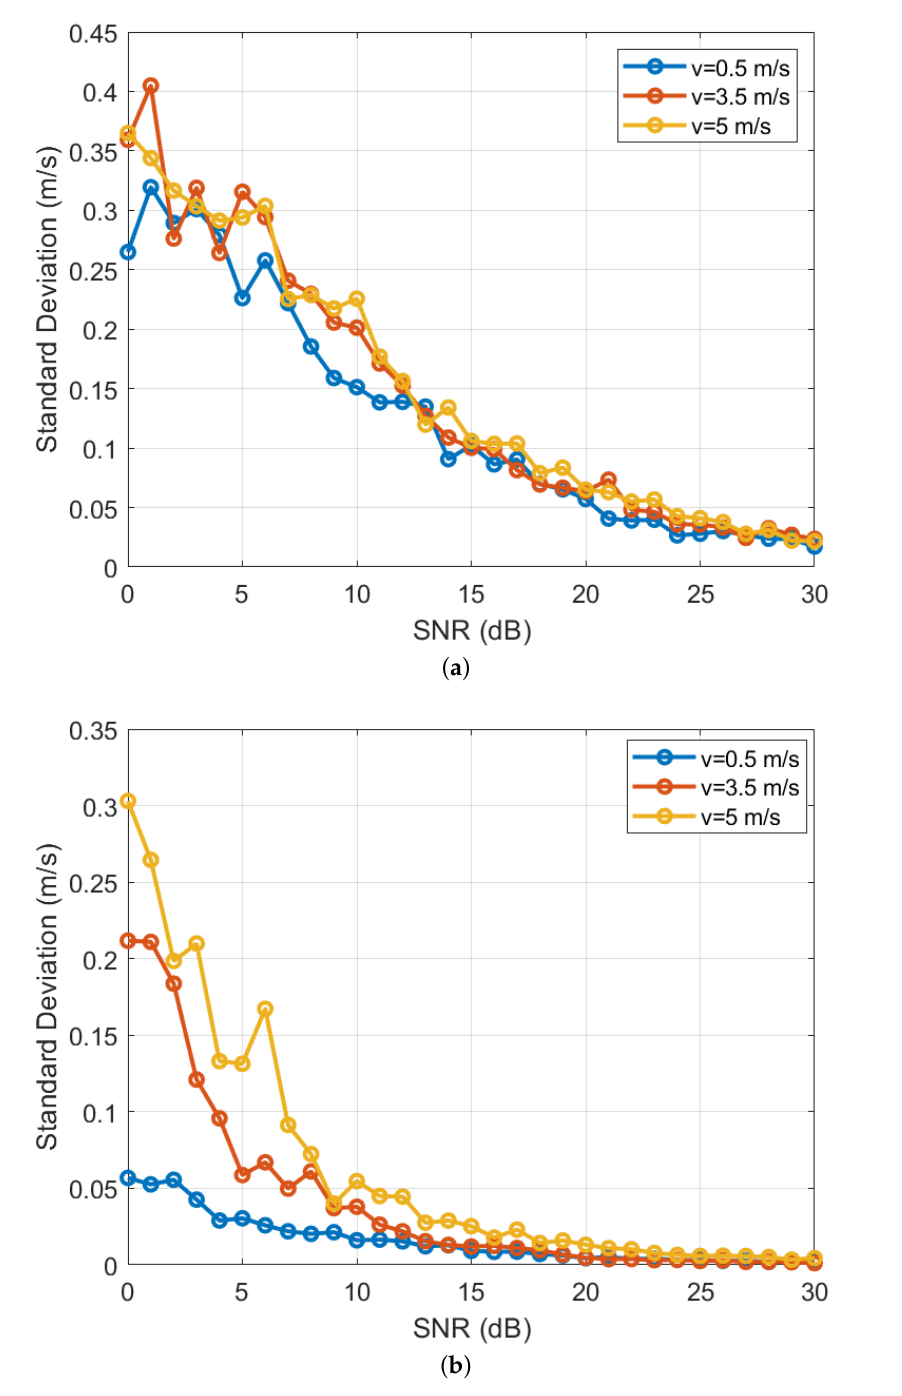
Figure 8. The standard deviation of estimated velocity under different SNR and different velocity values (0.5 m/s, 3.5 m/s and 5 m/s): ( a ) conventional signal; and ( b ) orthogonal combined